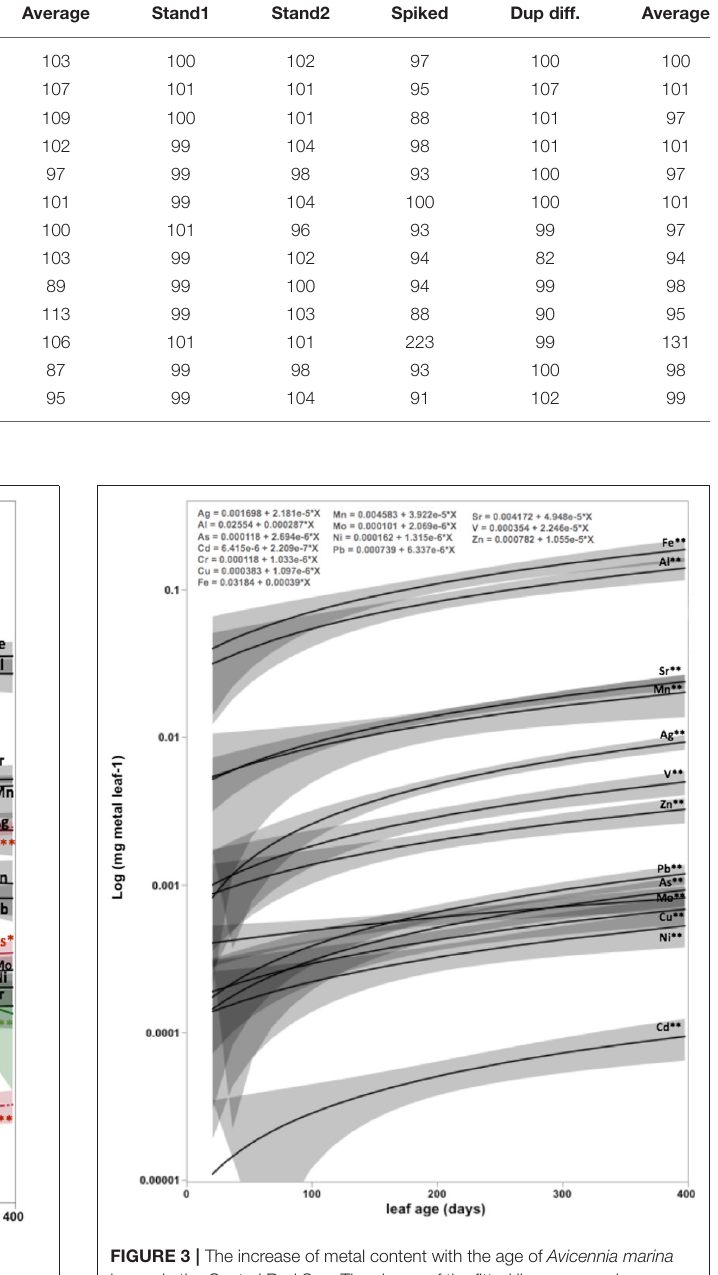
FIGURE 2 | The increase or decrease in the concentration of metal elements with the age of Avicennia marina leaves in the Central Red Sea. The slopes of the fitted linear regressions provide an estimate of metal accumulation rate (units mg metal gDW − 1 ). Results from ANOVA testing differences during leaf